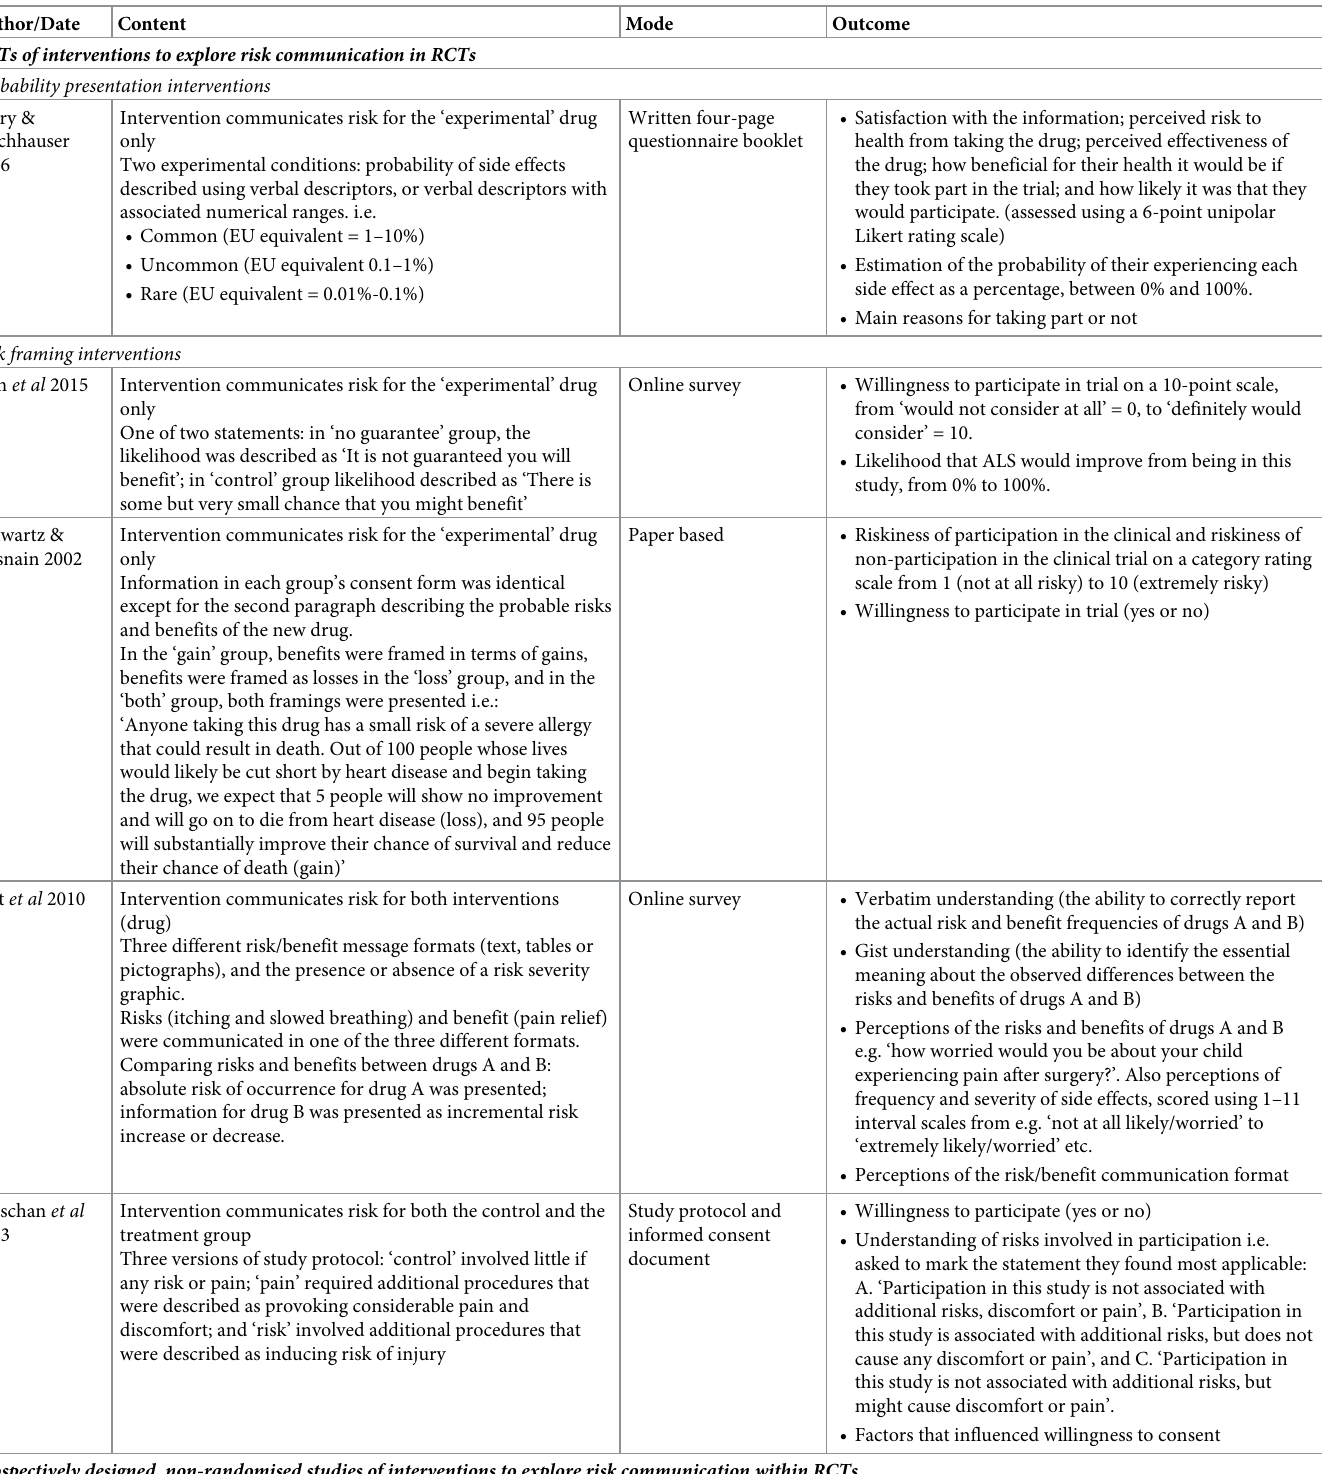
Table 3. Types of intervention(s) reported in included